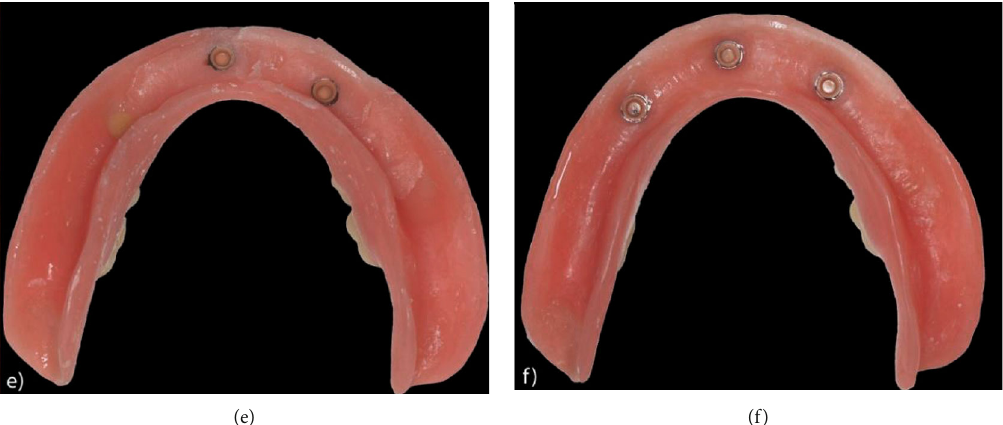
Figure 3: (a – c) Capture sequence for the O-rings with cylinders; (d) central Equator attachment capture; (e) left Equator attachment; (f) right Equator attachment capture.